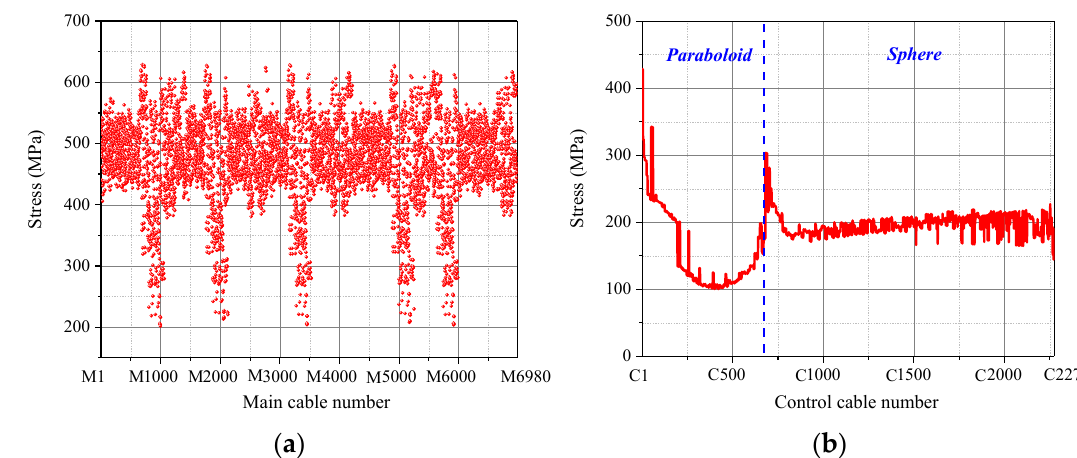
Figure 16. Stress distribution of cables: ( a ) stress distribution of main cables; ( b ) stress distribution of control cables.